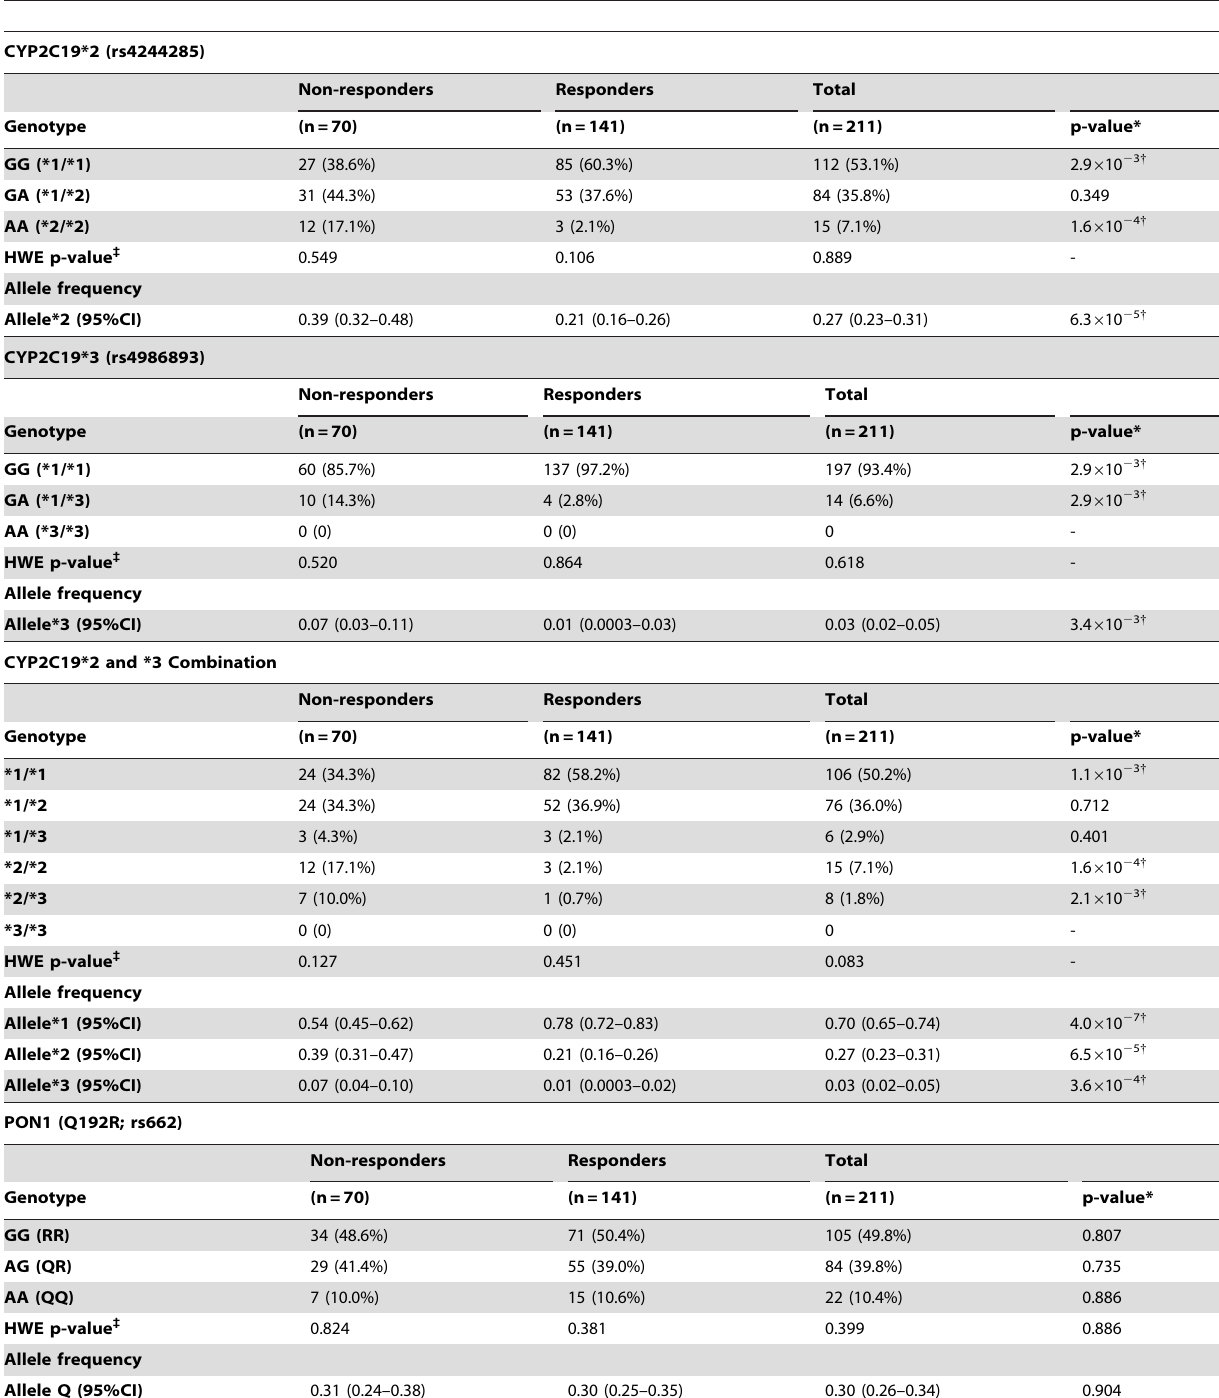
Table 2. Distribution of CYP2C19*2, *3 and PON1 genotypes in clopidogrel responders and non-responders.